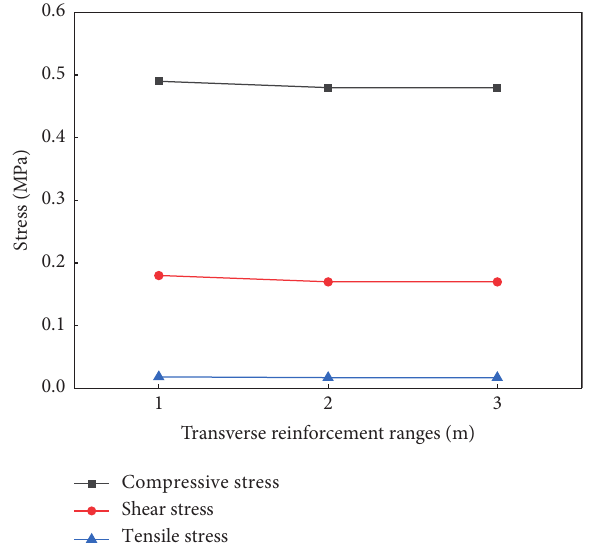
Figure 7: Stresses under transverse reinforcing ranges of 1 m, 2m, and 3